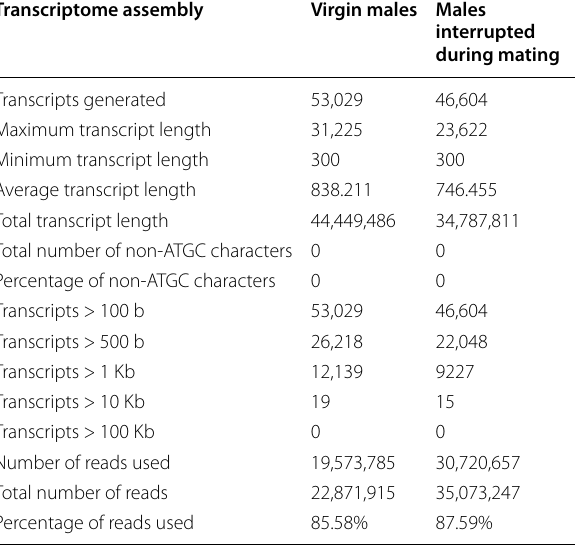
Table 1 Summary of S. litura transcriptome